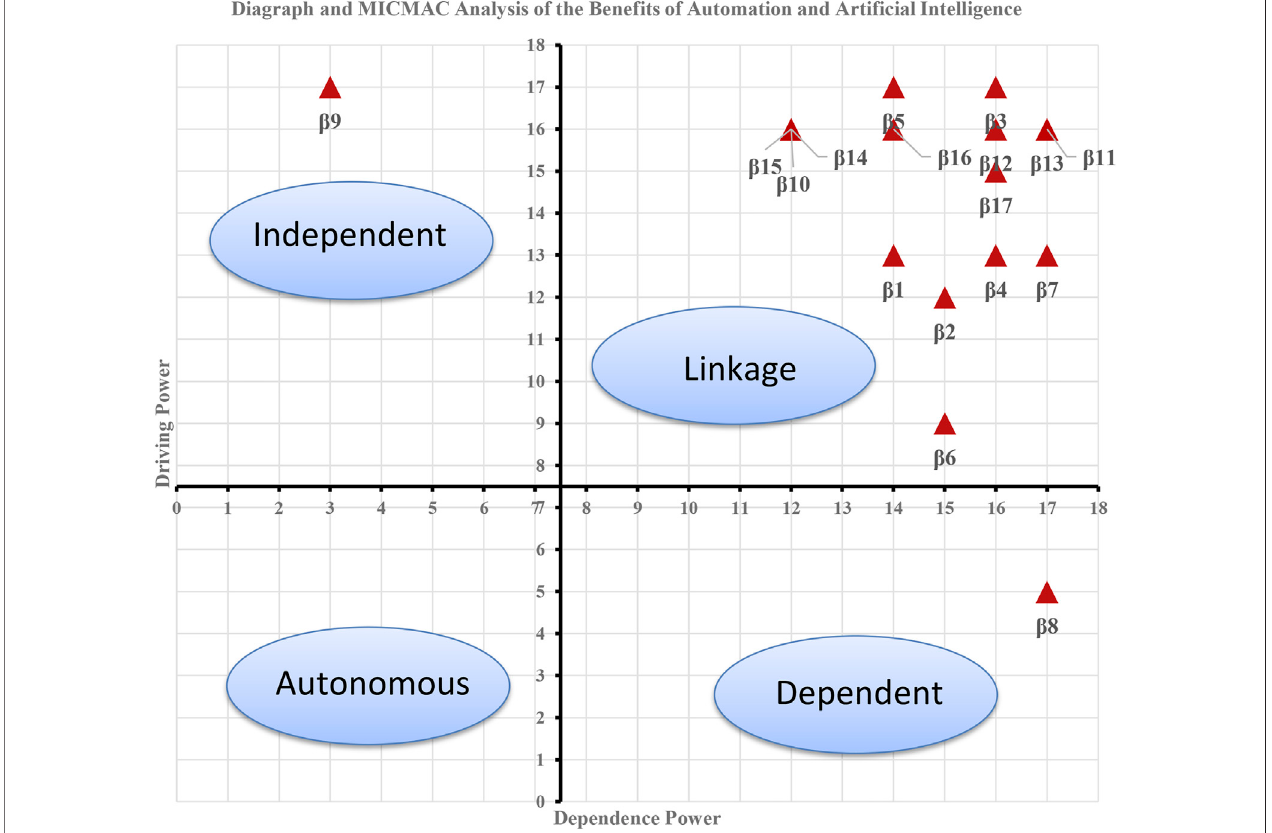
FIGURE 3 | Diagraph and MICMAC analysis of the bene fi ts of automation and arti fi cial intelligence.